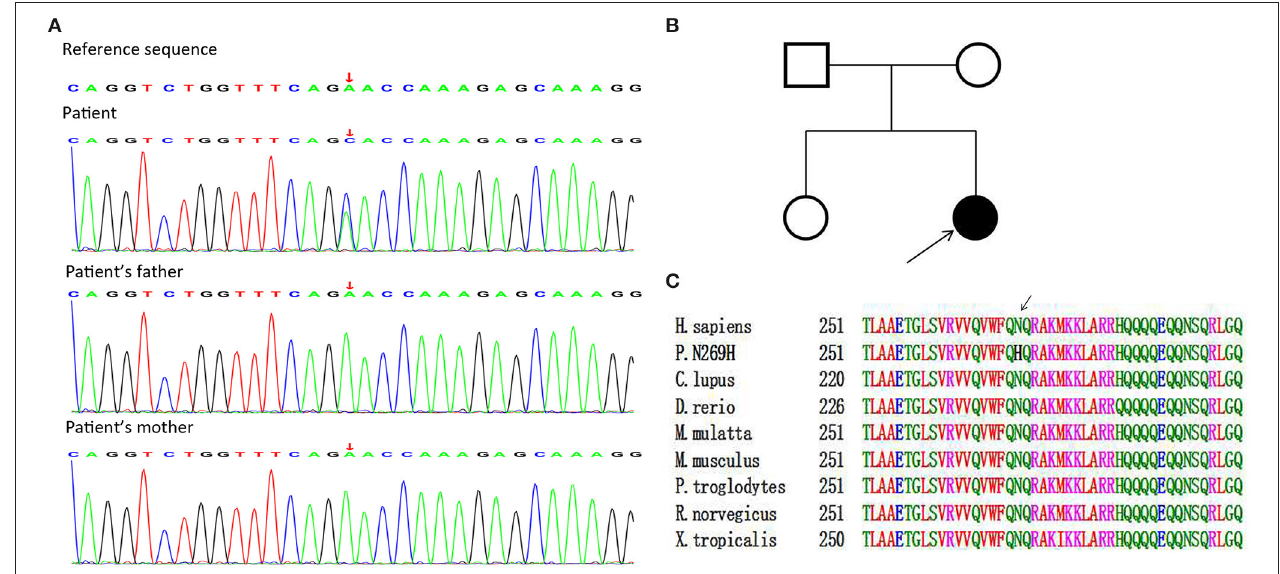
FIGURE 2 | Genetic analysis. (A) Trio-based whole genome sequencing showing a heterozygous variation in the fifth exon of the LMX1B gene (805A > C [p.asn269his]) in the patient, but not her parents. (B) Patient pedigree. (C) Amino acid sequences of the LMX1B protein in different species, showing the variation was in the highly conserved